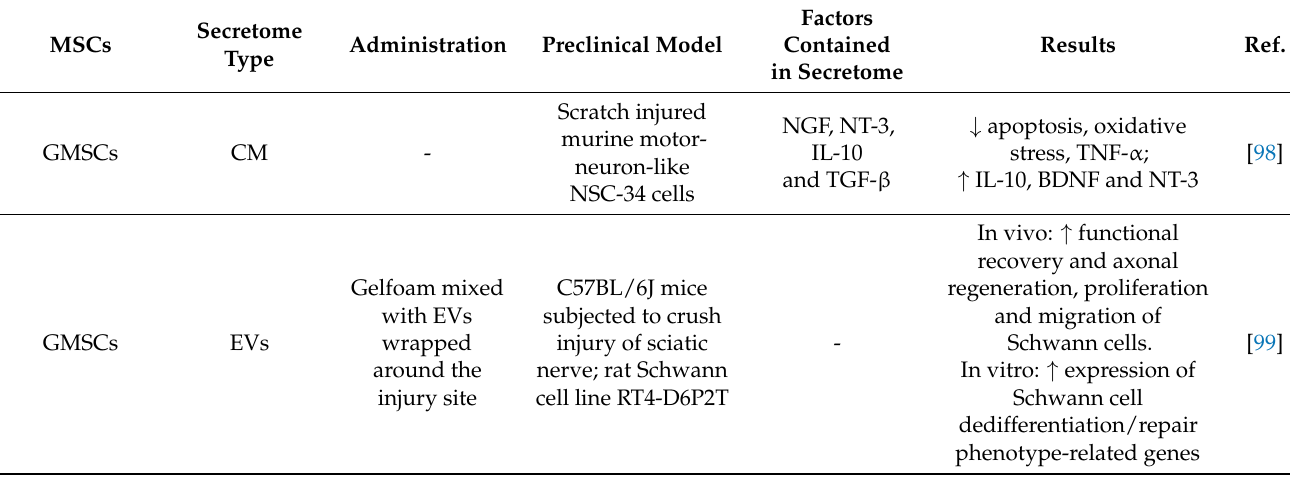
Table 5. Overview of studies involving other dental MSCs